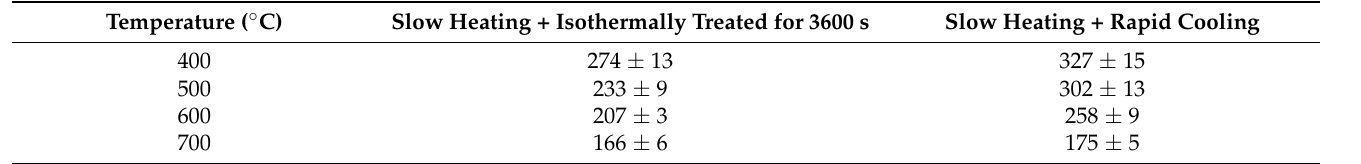
Table 4. Microhardness results for the different tempering paths.